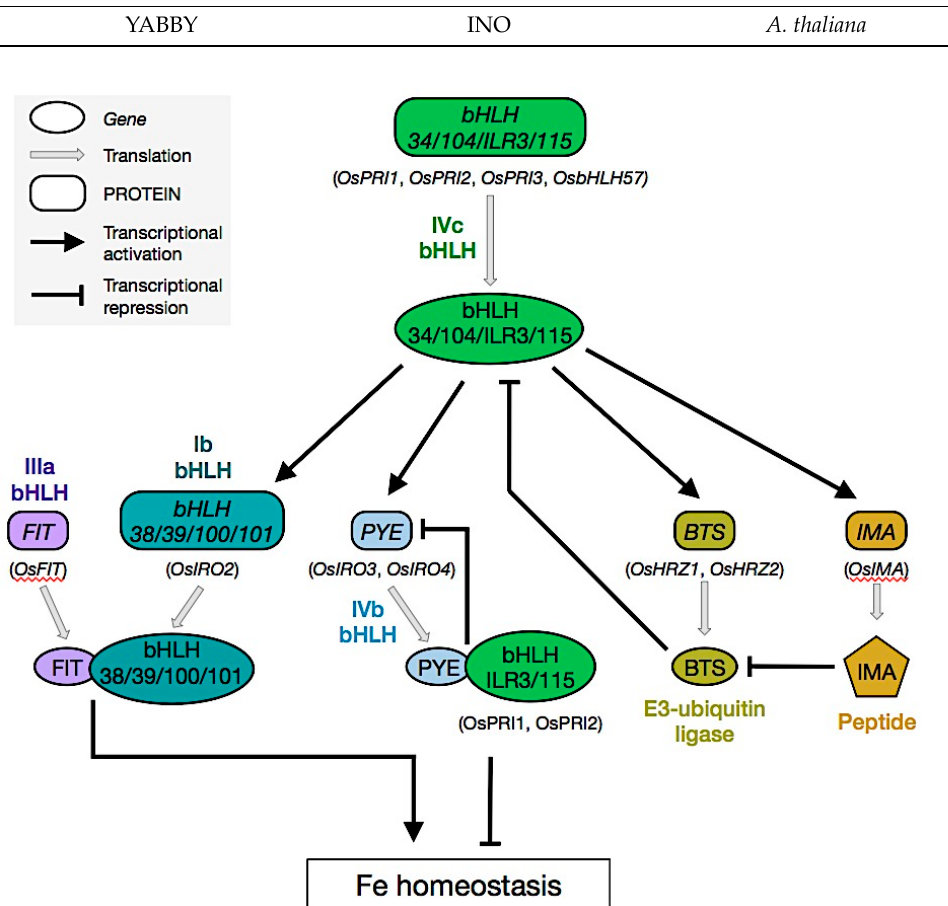
Figure 2. Transcriptional regulation of iron homeostasis: conserved mechanisms between grass and non-grass species. Upstream from the Fe homeostasis transcriptional regulatory network is clade IVc bHLH transcription factors (i.e., the Arabidopsis IDT1/bHLH34, bHLH104, ILR3/bHLH105 and bHLH115, and the rice OsPRI1/OsbHLH60, OsPRI2/bHLH58, OsPRI3/OsbHLH59 and bHLH57). Among the conserved target genes of clade IVc bHLH between grass and non-grass species are: (i) Clade Ib bHLHs (i.e., bHLH38 , bHLH39 , bHLH100 and bHLH101 , and the rice OsIRO2 / OsbHLH56 ) whose encoded proteins interact with FIT/OsFIT to activate the expression of Fe uptake genes. (ii) Clade IVb bHLHs (the Arabidopsis PYE , and rice OsIRO3 and OsIRO4 ) whose encoded proteins interact with clade IVc bHLH (i.e., the Arabidopsis ILR3/bHLH105 and bHLH115, and the rice OsPRI1 and OsPRI2) to negatively regulate Fe homeostasis and their own expression. These inter- actions allow balancing Fe uptake and Fe storage to meet the Fe demand of the plant for its growth and development. (iii) Hemerythrin E3-ubiquitin (E3-ubi) ligases (i.e., the Arabidopsis BTS , and the rice HRZ1 and HRZ2 ) that are involved in the degradation of clade IVc bHLH transcription factors (i.e., the Arabidopsis ILR3/bHLH105 and bHLH115, and the rice OsPRI1 and OsPRI2). (iv) IMAs that encode peptides that interact with and negatively modulate the hemerythrin E3-ubiquitin ligase activities (i.e., the Arabidopsis BTS, and the rice HRZ1 and HRZ2) that partici- pate in the inter-organ signalling of cellular Fe status for fine-tuning Fe uptake in roots.